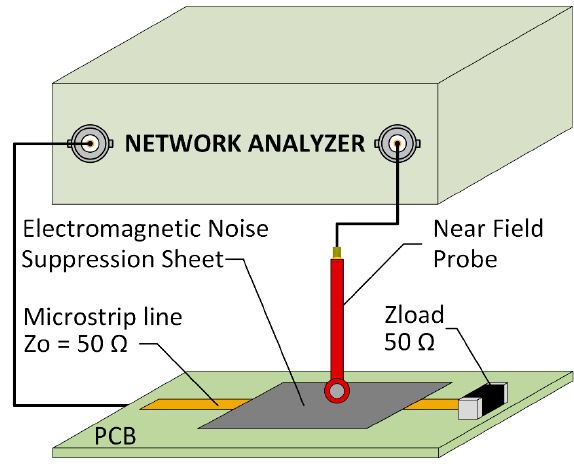
Figure 4. Re-radiation measurement setup.